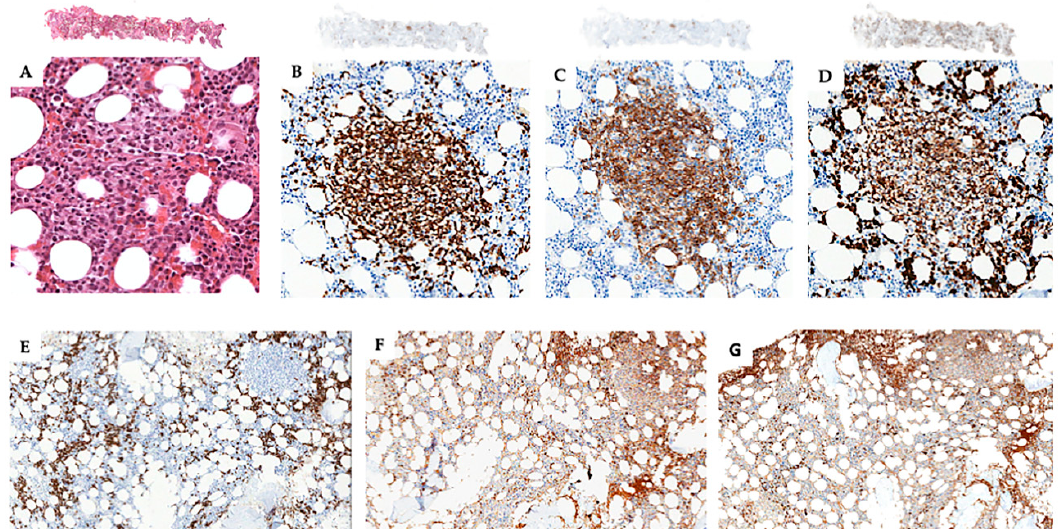
Figure 4. Bone marrow trephine biopsy showing focal nodular infiltration ( A H&E) of CD3+ ( B ), CD20+ ( C ), CD79a+ ( D ) neoplastic T cells associated with a polytypical reactive CD138+ plasmacytosis ( E ) with polytypical expression of kappa ( F ) and lambda ( G ) light chains (original magnification A , B , C , and D ×200; E , F , and G ×100; insets ×5).